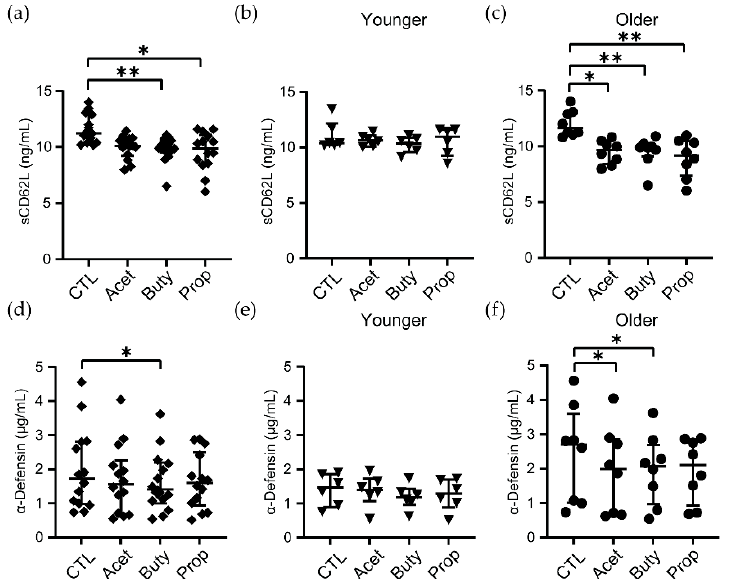
Figure 4. Pathological concentrations of SCFAs significantly reduced the release of sCD62L and α -defensin 1–3 by neutrophils from older women. ( a ) Quantification of sCD62L released by SCFA-treated neutrophils and stratified by younger ( b ) and older women ( c ), measured by ELISA. ( d ) Quantification of α -defensin 1–3 released by SCFA-treated neutrophils and stratified by younger ( e ) and older women ( f ) after 3 h, measured by ELISA. Each dot represents a different patient ( n = 14; younger = 6, older = 8). Non-parametric paired Friedmann test was used; * p ≤ 0.05, ** p ≤ 0.01. CTL: control; Acet: acetate 25 mM; Buty: butyrate 25 mM; Prop: propionate 25